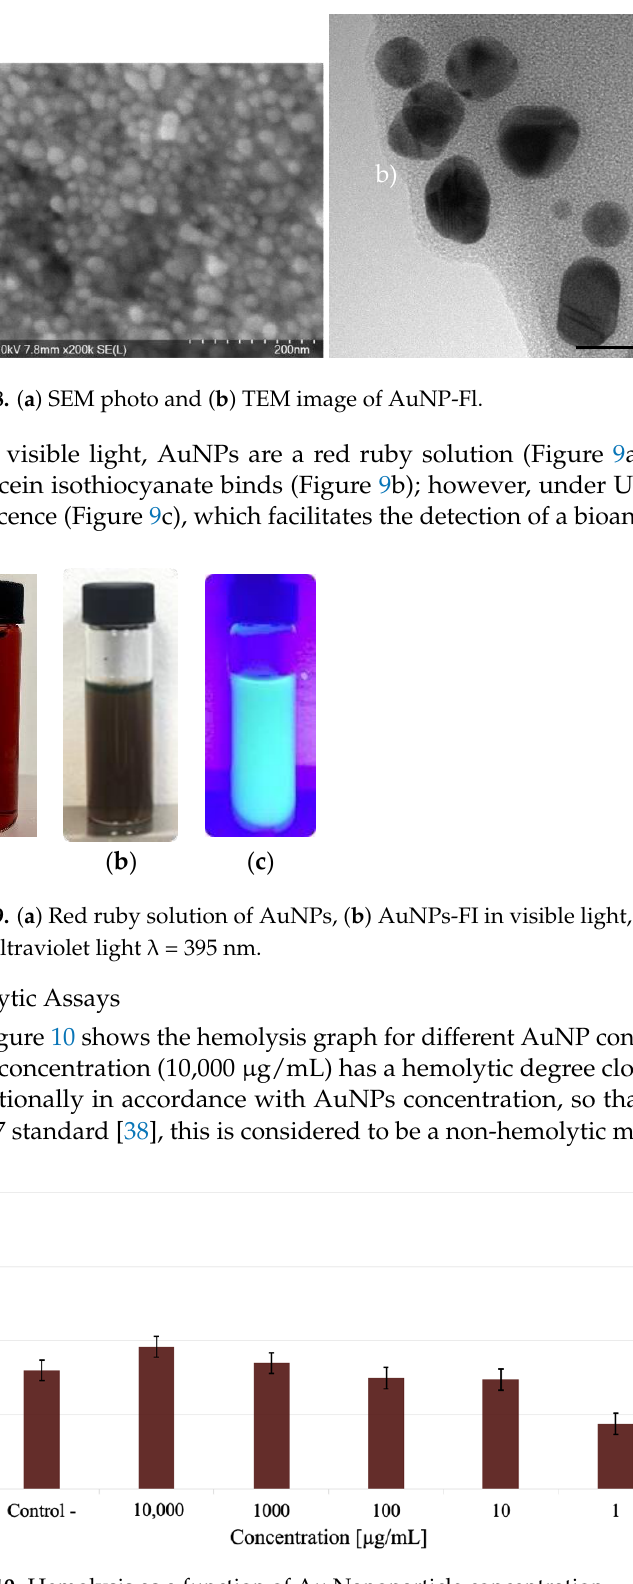
Figure 7. Particle size distribution of AuNPs-FI.